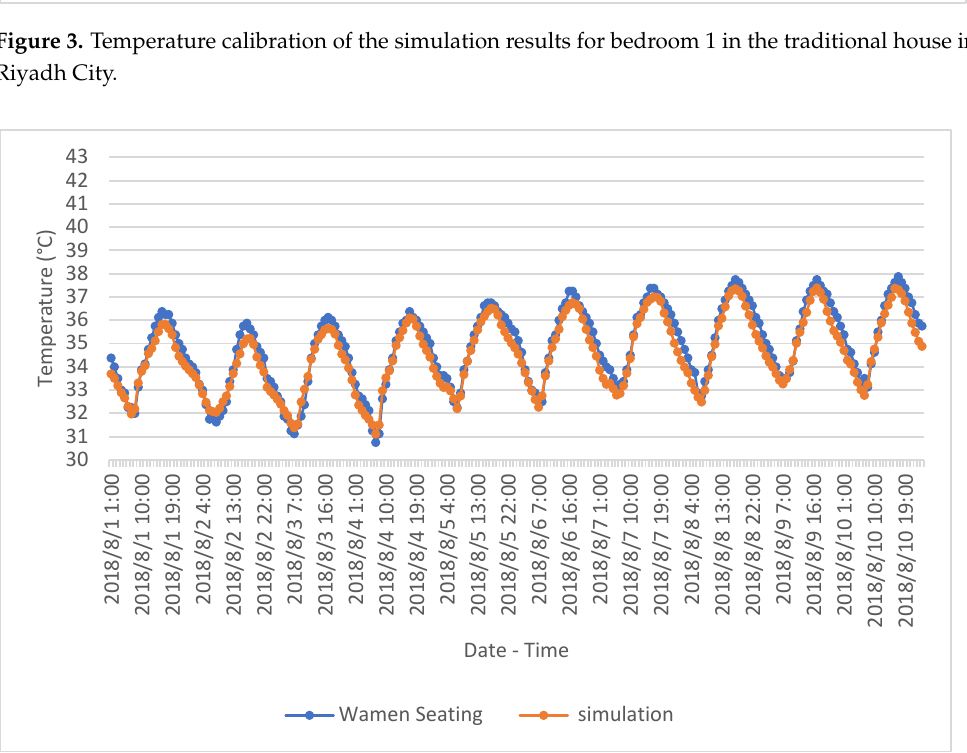
Figure 4. Temperature calibration of the simulation results for the family seating area in the traditional house in Hail City.